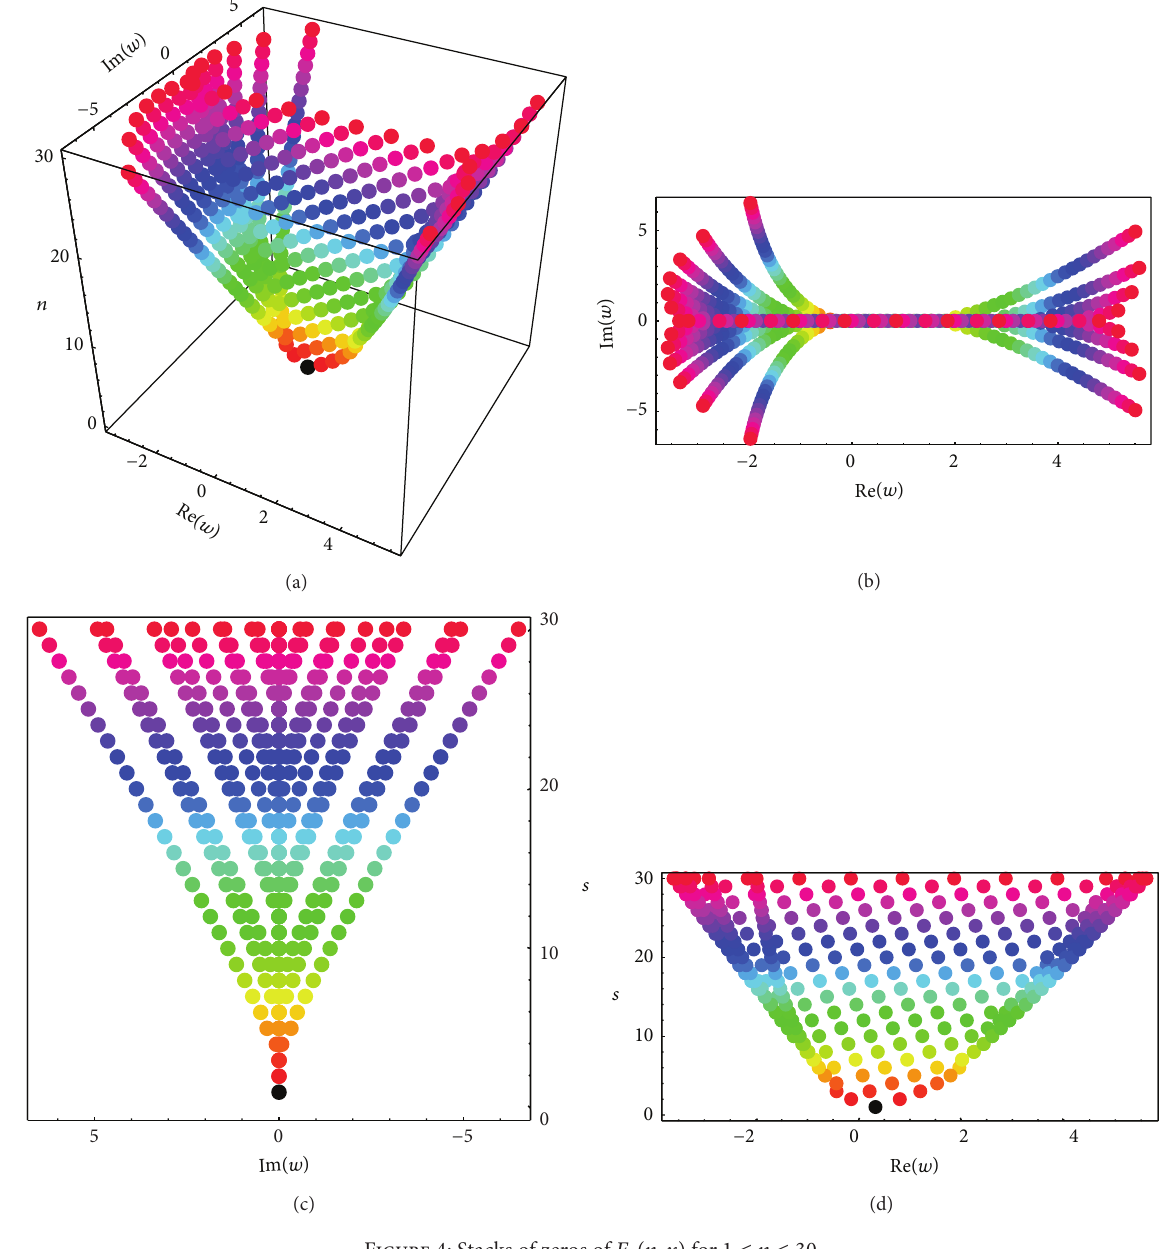
Figure 4: Stacks of zeros of 𝐸 𝑞 (𝑛,𝑥) for 1 ≤ 𝑛 ≤ 30